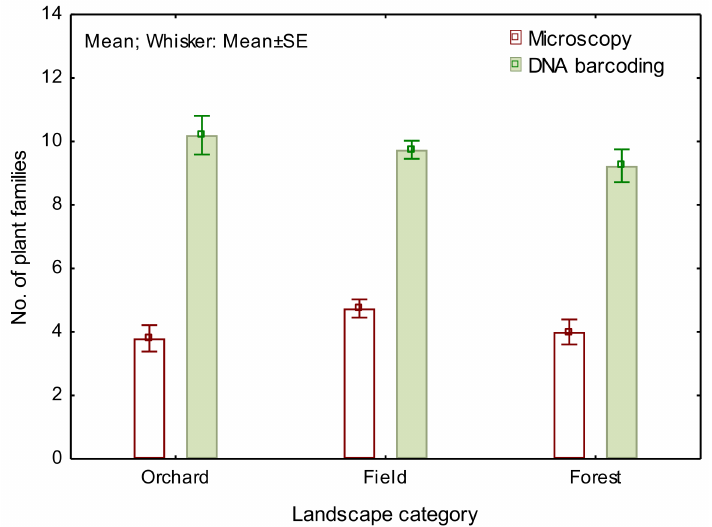
Figure 3. A number of plant families were determined with microscopy and DNA metabarcoding in bumble bee pollen forage from different landscape categories. Table 1. Statistical analysis of variance of different pollens at a different level of plant taxa determina- tion. The analyses at the Family and Genera level are made using ANOVA, the analyses at Species level are made using Wald statistics from LOG Generalized linear model.